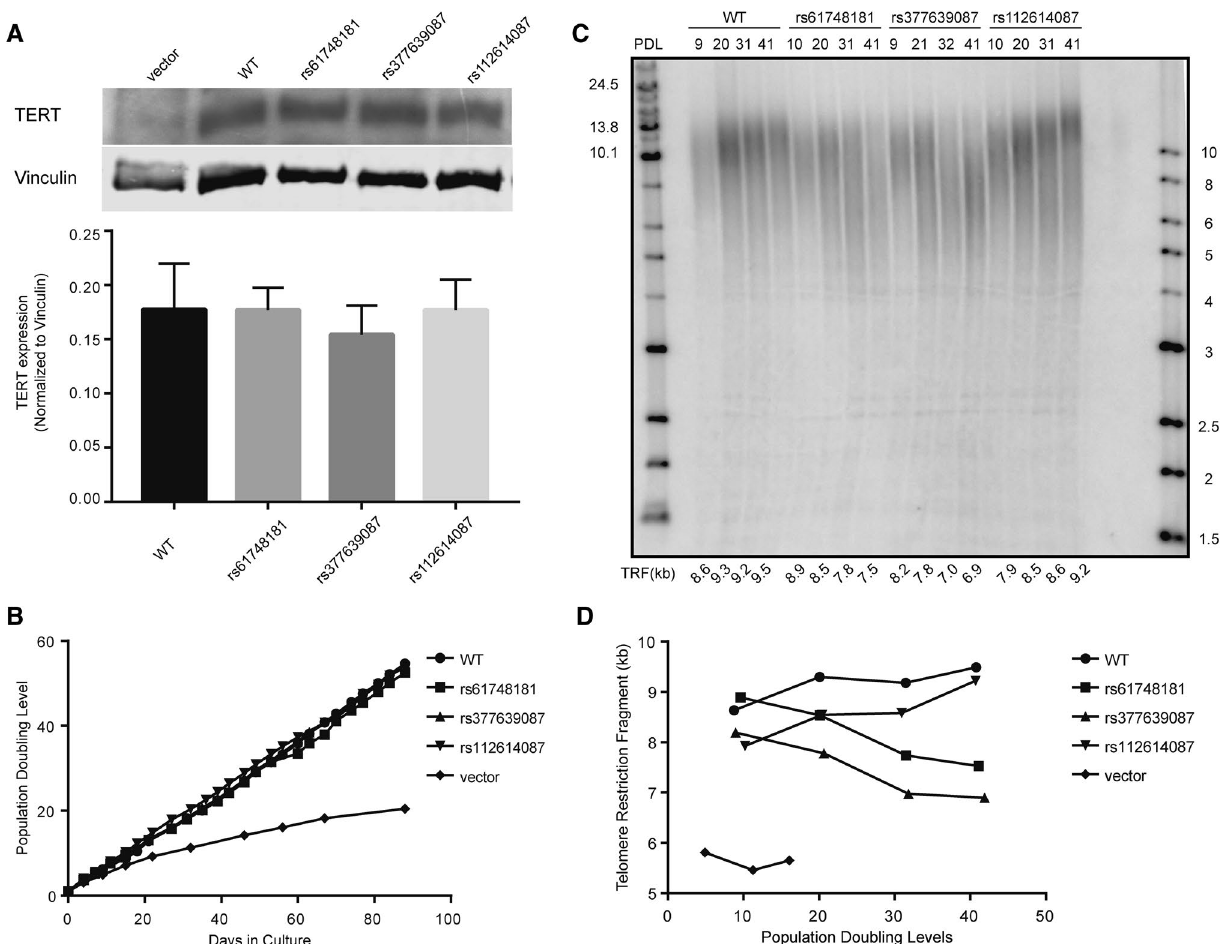
Figure 1. Restoration of recombinant telomerase mediated by the TERT variants in BJ cell lines. ( A ) Recombinant expression of TERT in BJ fibroblasts. TERT expression levels (127 kDa) were normalized to those of vinculin (124 kDa) and the data are presented as mean ± SEM (n = 6). fluorescent & ECL ones). TERT and vinculin signals were differentiated with the use of differently labeled antibodies (chemiluminescent and fluorescent, respectively) and processed accordingly with different detection modalities. Full sets of data were available in the supplementary information (Supplementary Fig. 3) ( B ) Cellular growth kinetics of BJ cell lines expressing recombinant SNP-version of telomerase. ( C ) Telomere lengths in the cells at approximately every 10 PDLs were measured by TRF. Population doubling level (PDL) and telomere lengths (telomere restriction fragments, TRF) for each sample are illustrated. ( D ) Changes in telomere length over cell divisions are